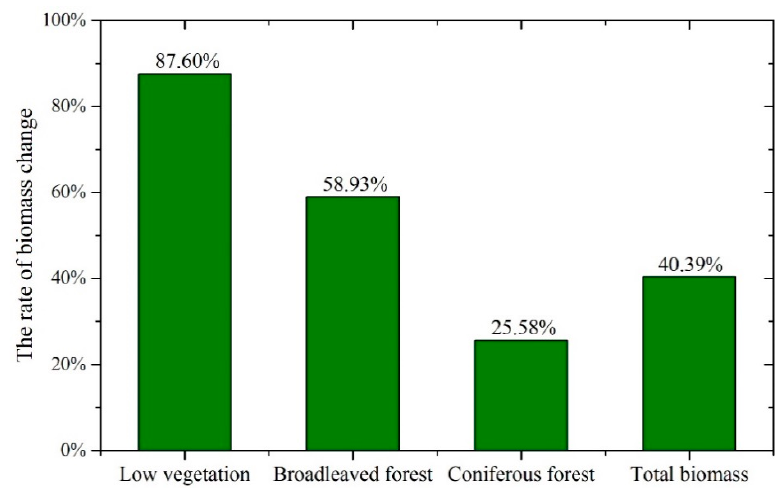
Figure 7. The seasonal change rate of vegetation biomass of the study area.